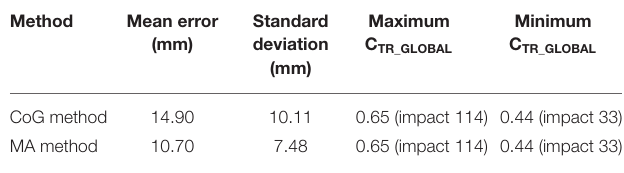
TABLE 1 | Post-processing results for no grid refinement, CoG method and the new MA approach.